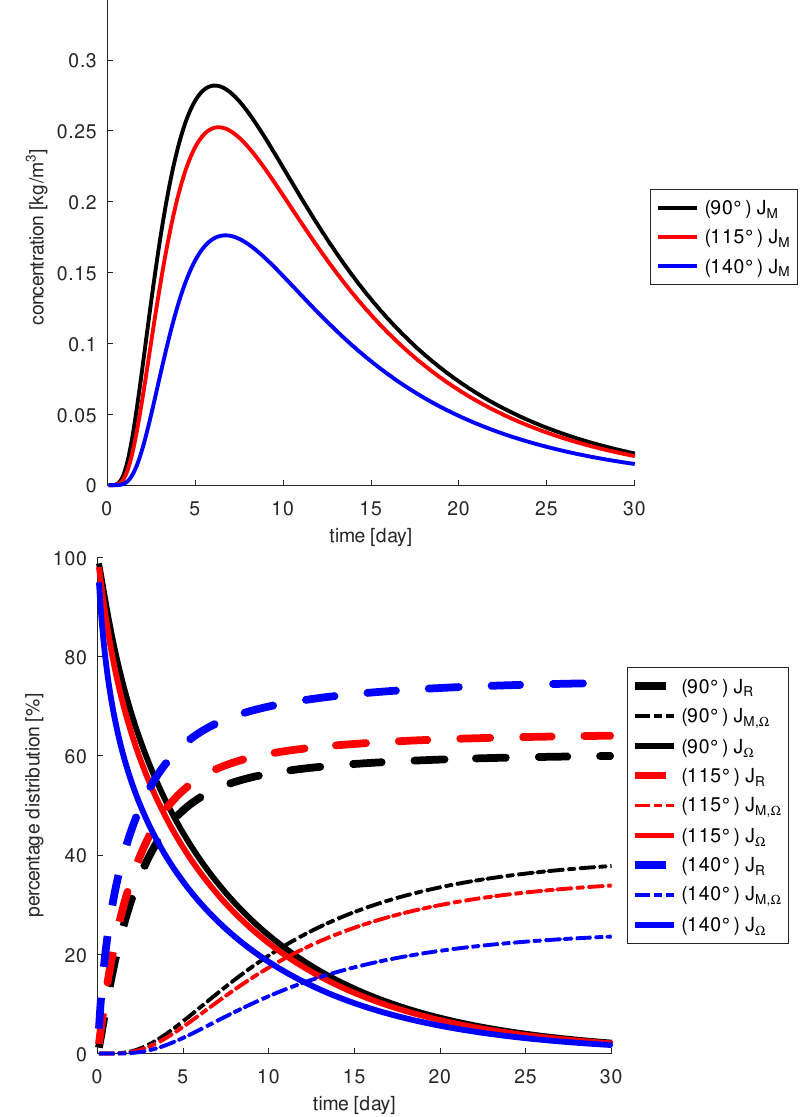
Figure 9. Top: drug concentration at the macula, J M and bottom: fraction of injected drug in the vitreous, J Ω , around the macula, J M , Ω , and lost through the retina, J R , as a function of penetration angle ψ z : with an injection angle of 90 ◦ (black) the largest amount of drug is inside the vitreous (black solid line) and also at the macula (black dashed dotted